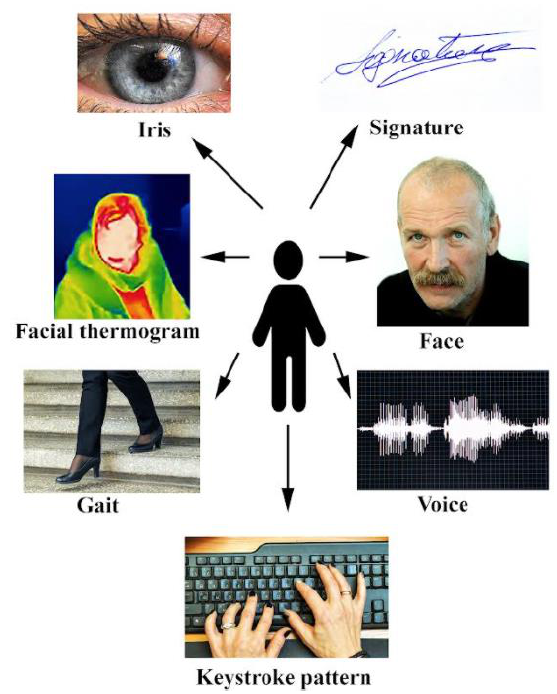
Figure 9. Other examples of biometric traits.